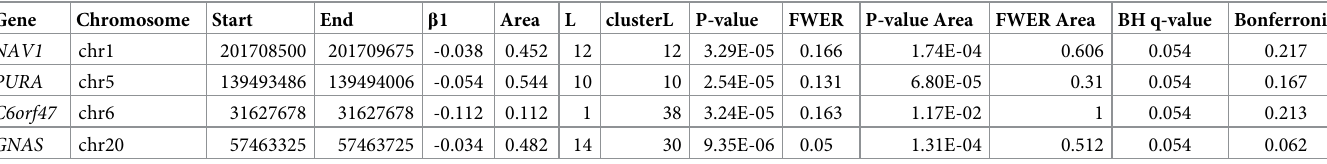
Table 3. ‘Bumphunter’ results of significant DMRs (BH q <